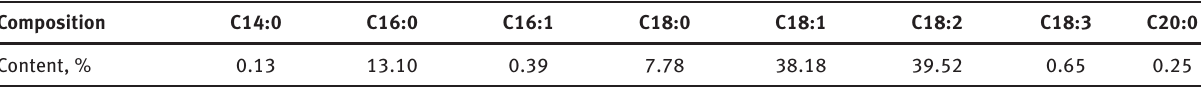
Table 2: Composition of fatty acids in Jatropha